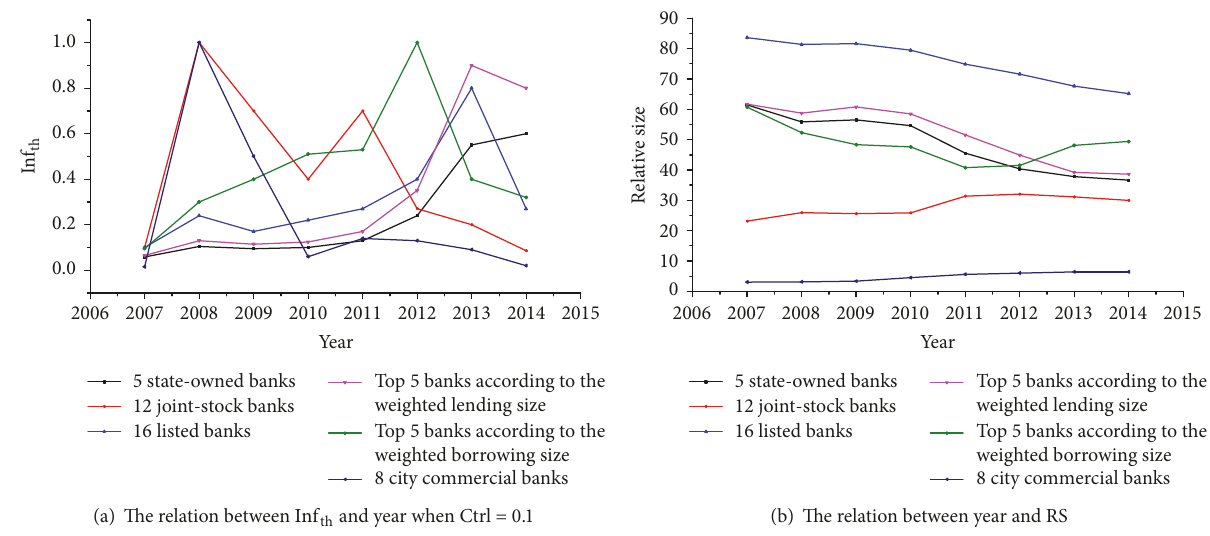
Figure 7: The relation between relative size (RS) and spillover effect (Inf th ) for banks receiving